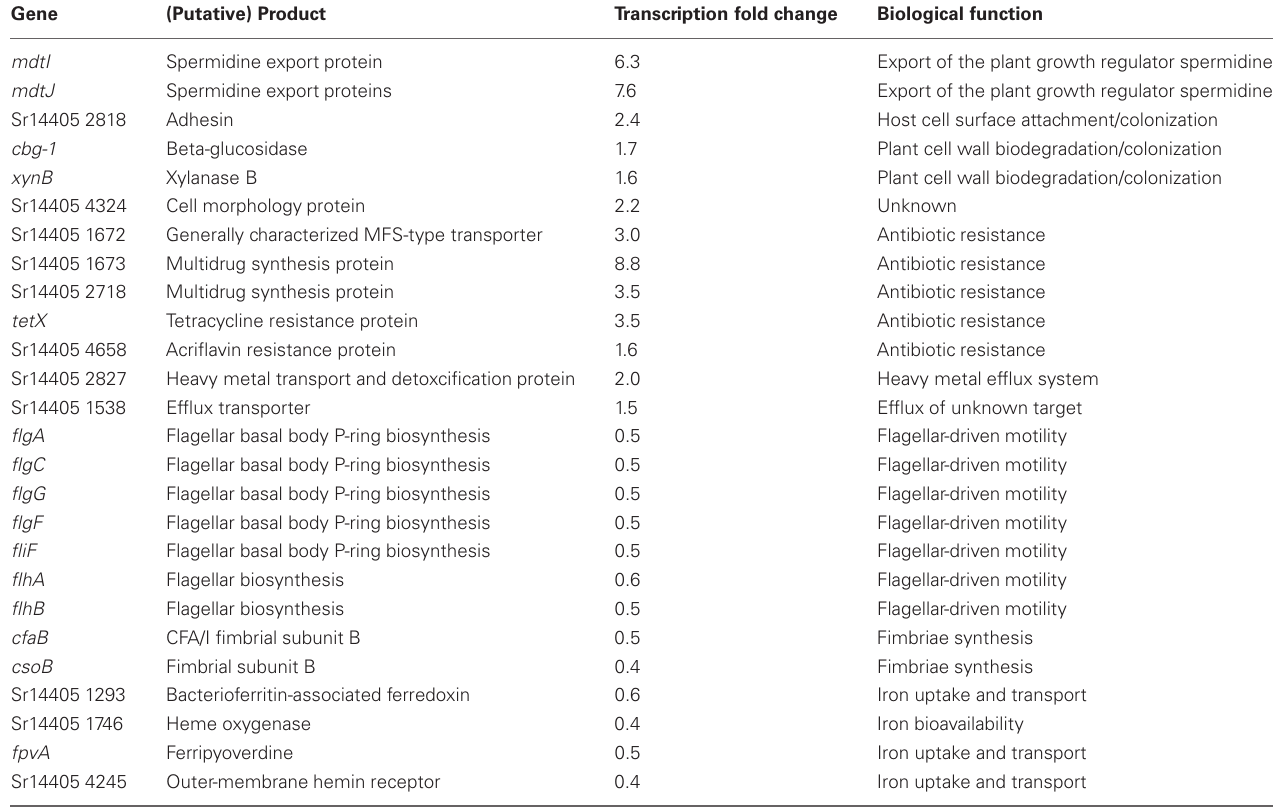
Table 2 | Selected S. rhizophila DSM14405 T genes with known biological roles impacted by plant root exudates.